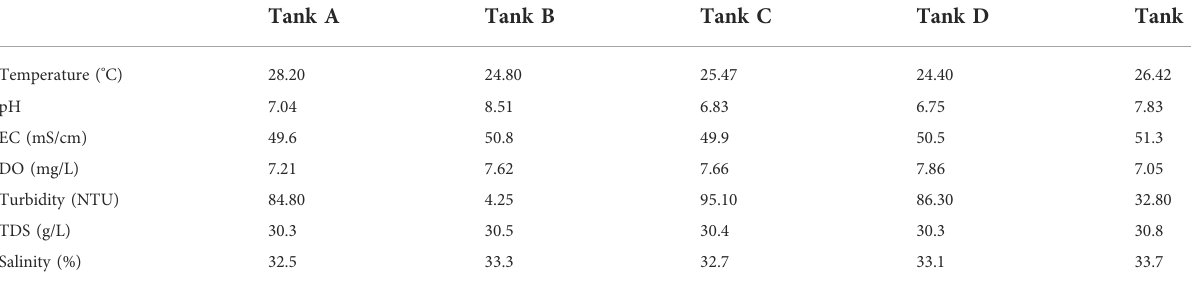
TABLE 1 The seven physicochemical factors studied in the fi ve tanks from Litopenaeus vannamei shrimp